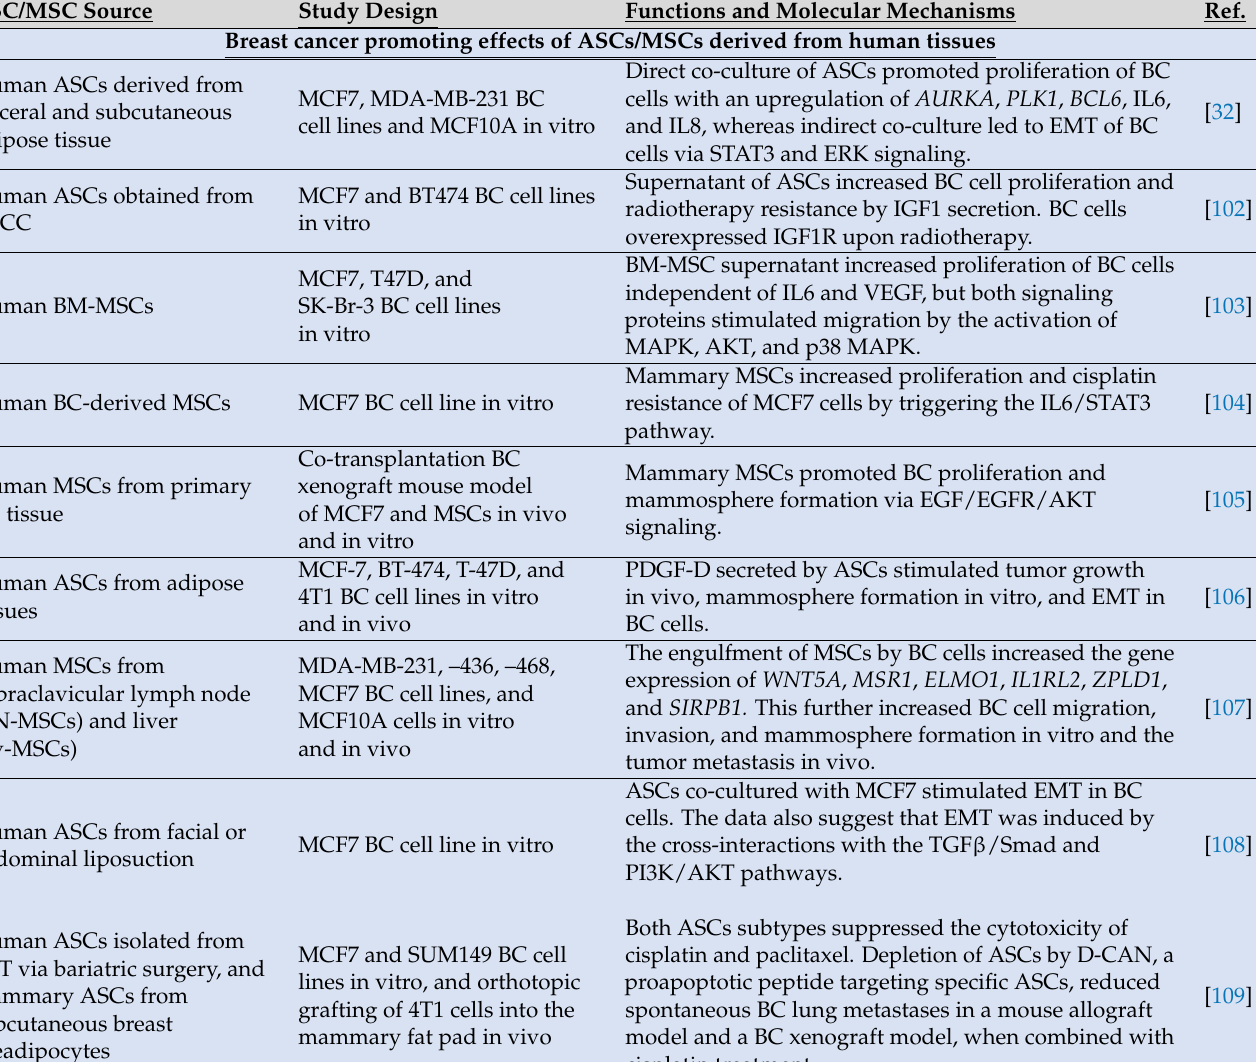
Table 1. Functional alterations of breast cancer cells induced by